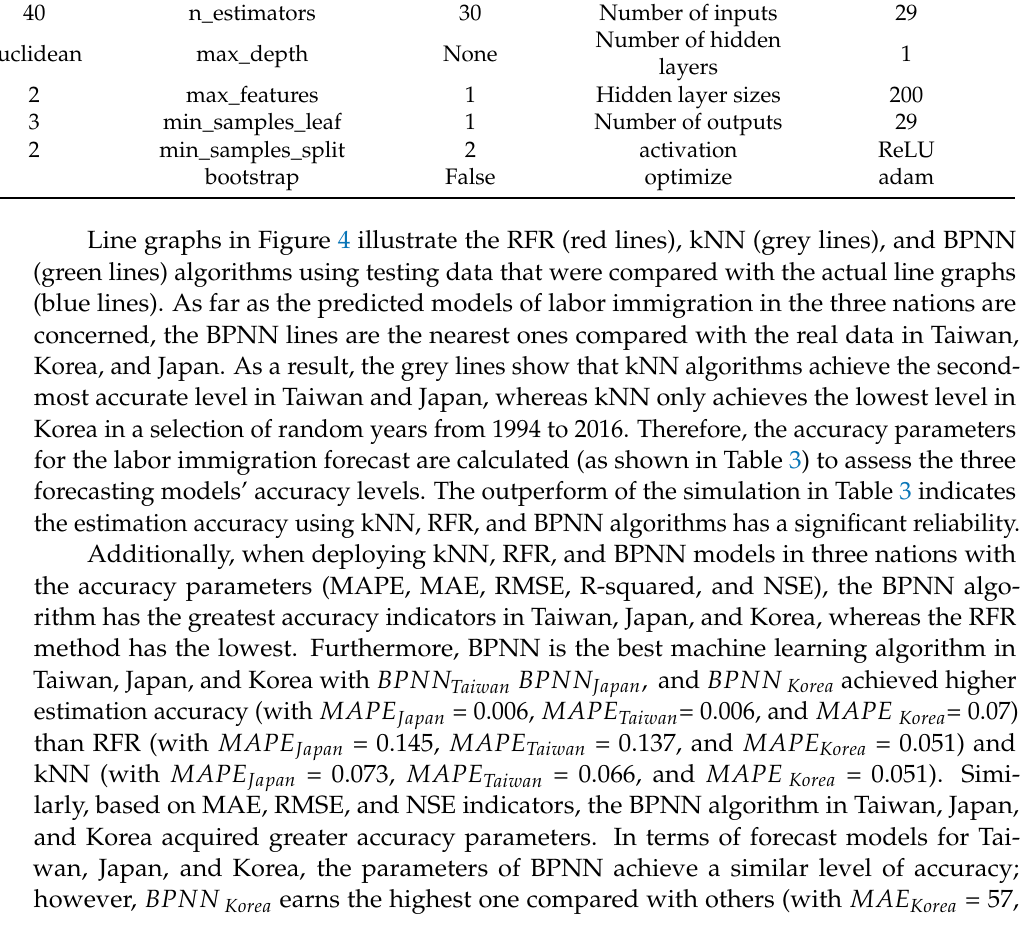
Table 2. The optimum component for three models.